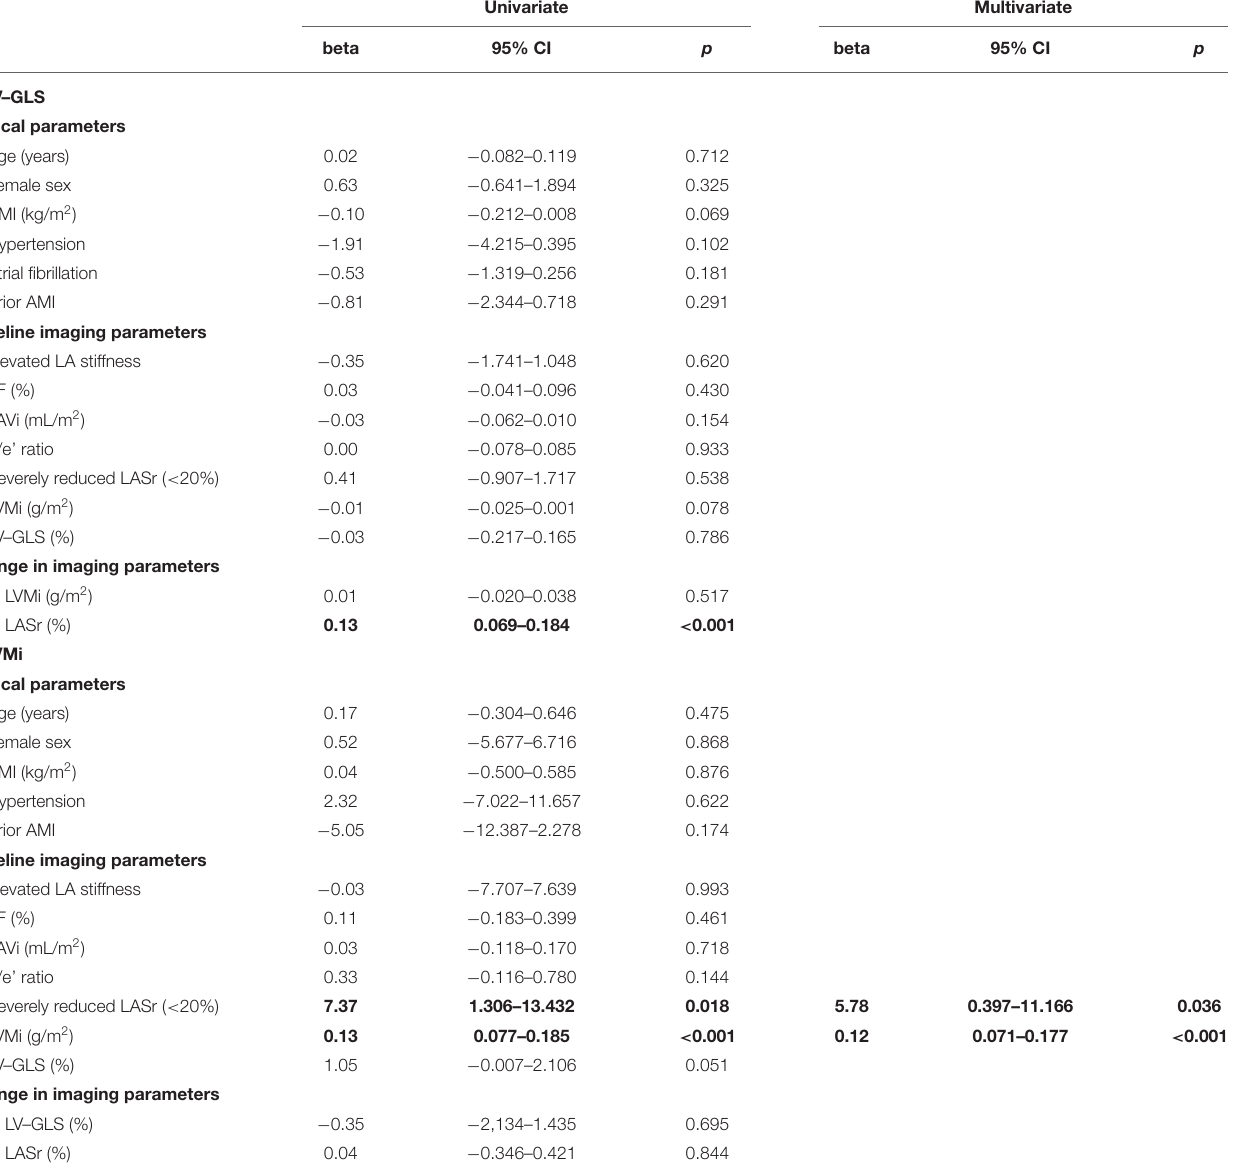
TABLE 4 | Uni- and multivariate linear regression analysis of the association of comorbidities, echocardiographic parameters and LV reverse remodeling.